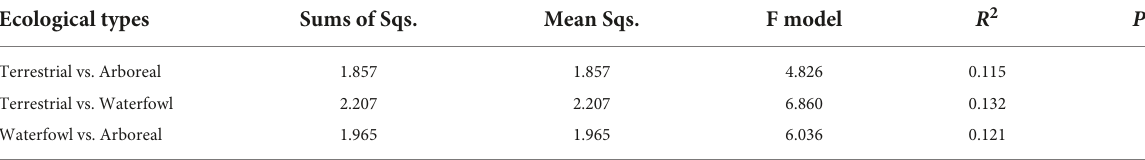
TABLE 1 PERMANOVAs exploring the effects of ecological types on birds intestinal bacteria community based on Bray–Curtis distance matrixes. Ecological types Sums of Sqs. Mean Sqs. F model R 2 P -value